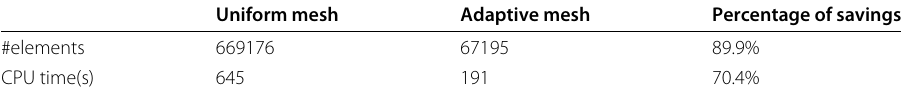
Table 6 Comparison of uniform and adaptive meshes with respect to number of elements and CPU time(s) when achieving 4.84E-6 L 2 error of density for the evolution of an isentropic vortex